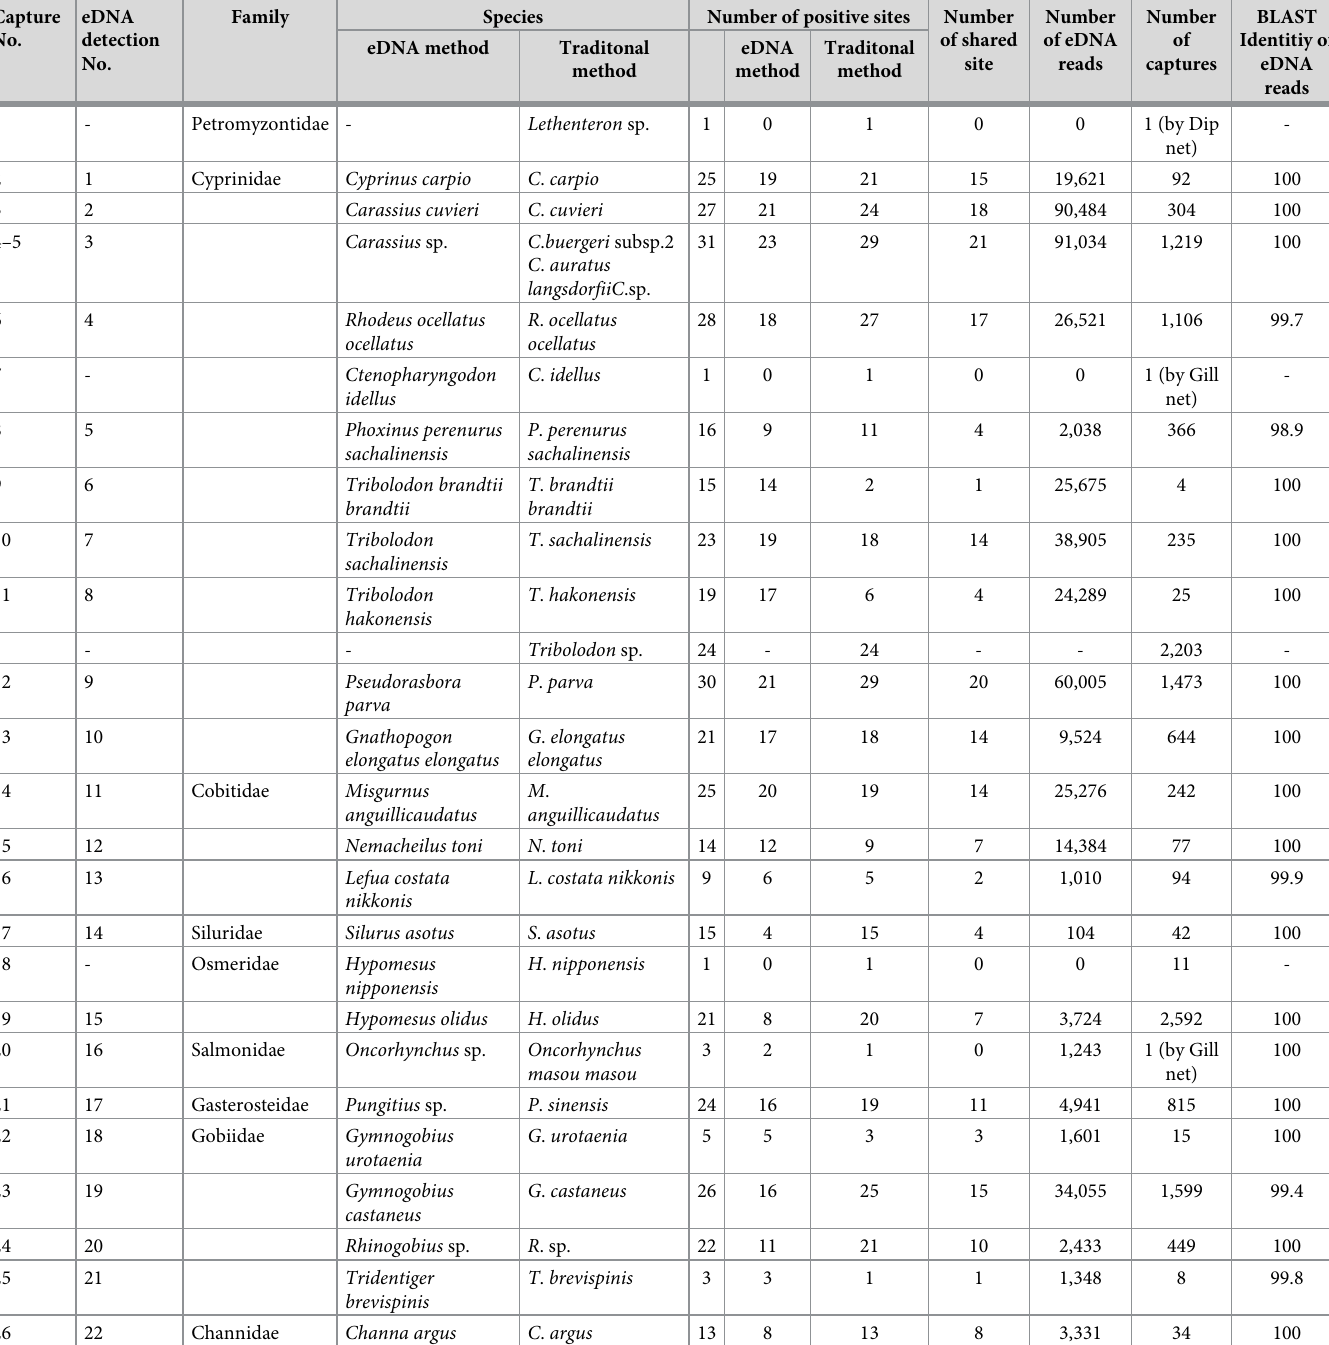
Table 5. The species list with the number of positive sites, shared sites for multiple capture methods and eDNA metabarcoding with total reads of high-throughput parallel DNA sequencing (HTS), and the number of captured individuals. Capture No.